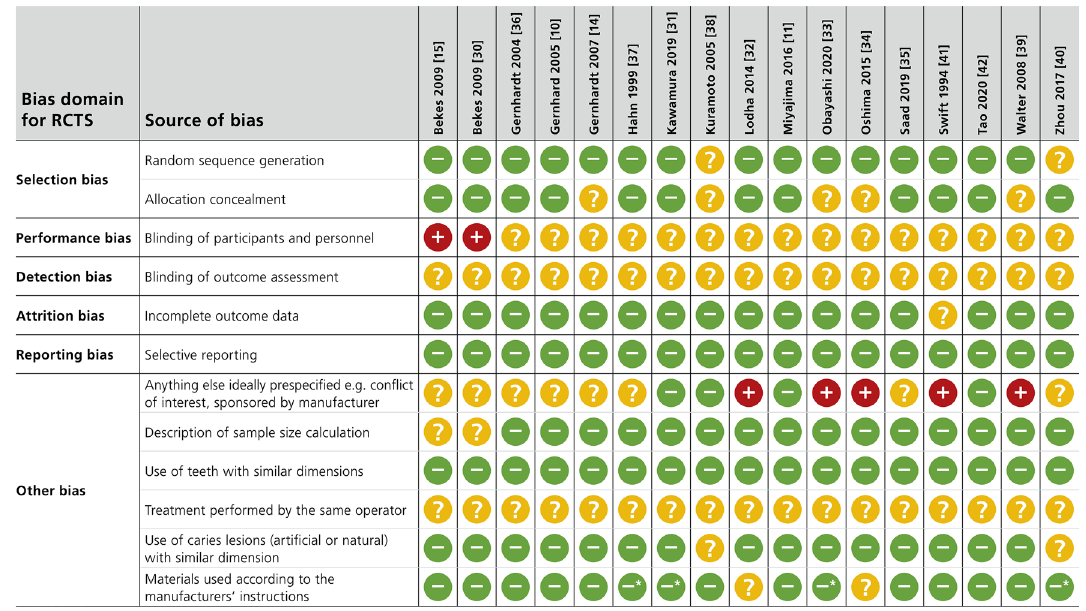
Figure 3. Risk of included studies. − high; + low; ? unknown. *in one group the material was used as recommended by the manufacture, in a second group the application of the tested material was